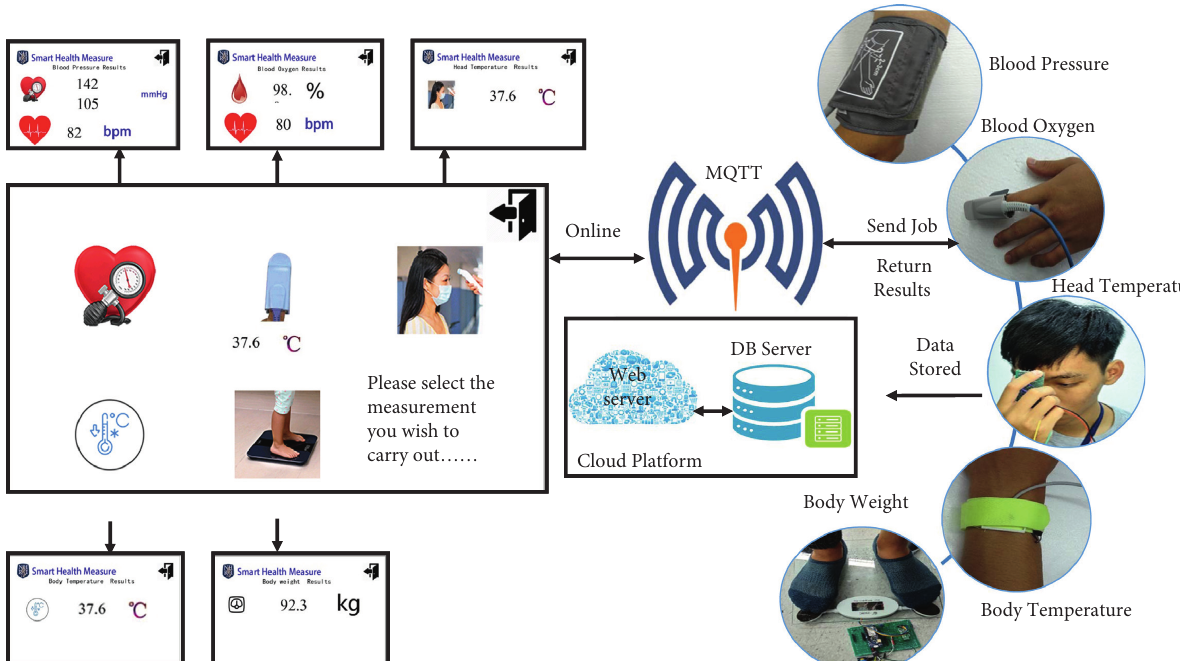
Figure 3: Operational flow implemented by users (checking essential vital signs) in the system proposed in this paper. Step 1: users access the RFID controller with their health ID card and select the measurement option on the TFT touch screen. The RFID controller sends the corresponding ID number via an MQTT broker over a Wi-Fi connection to notify the above devices (head temperature, body temperature, body weight, blood oxygen, and blood pressure sensors) to be ready for use. Users can use any of the above devices to detect their health status, after which the devices will send results via the MQTT broker and cloud platform over a Wi-Fi connection. All results are instantly displayed, either individually or in summary, on the TFTtouch screen of the RFID controller and on any browser running on a smartphone or desktop